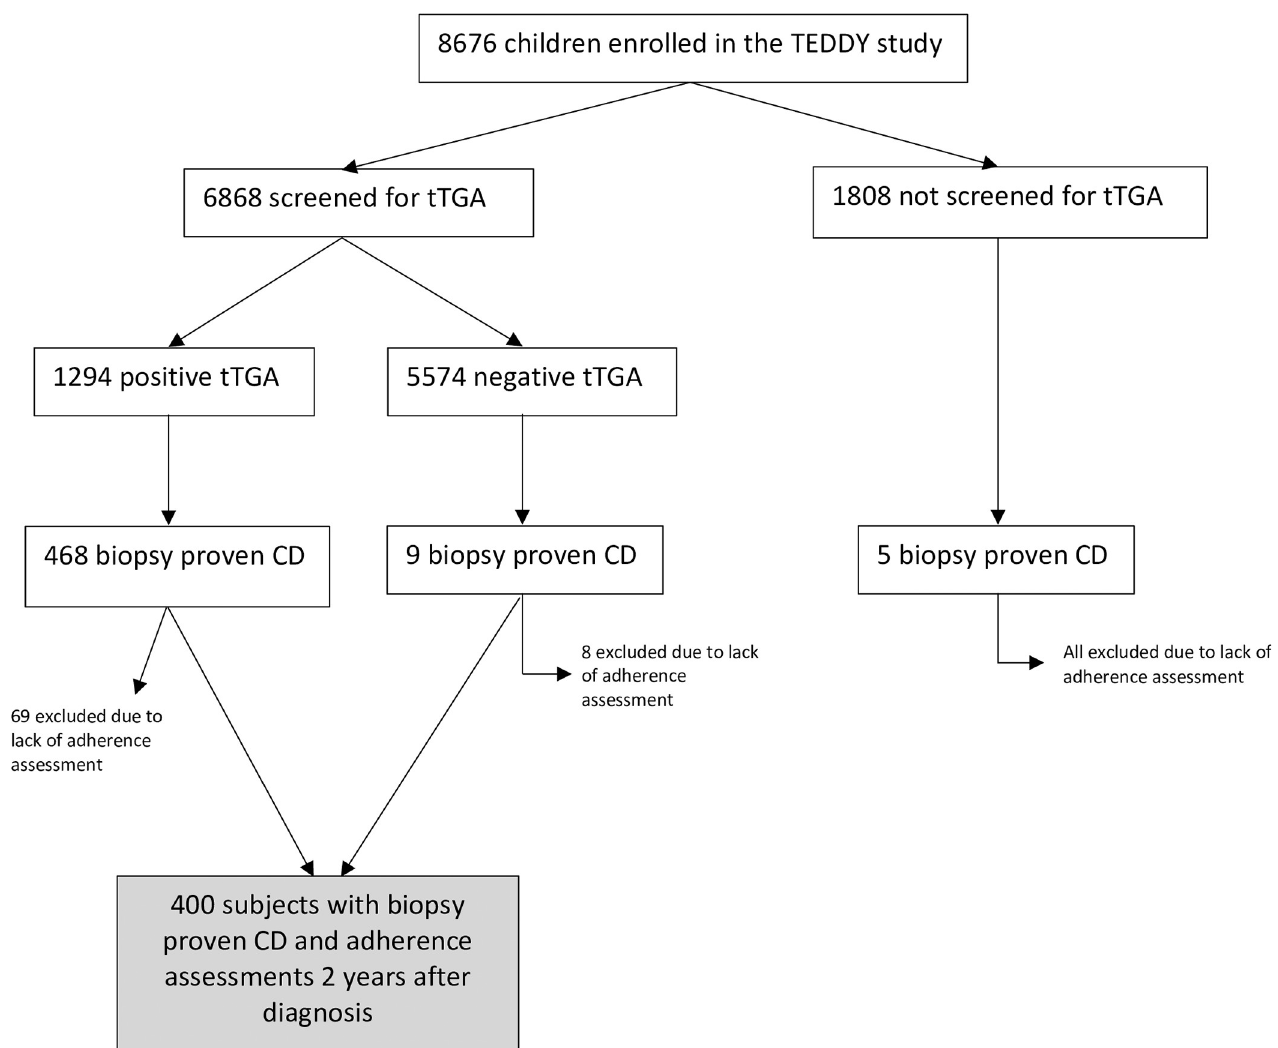
Fig 1. Study population. Inclusion and exclusion criteria for the current TEDDY study. Abbreviations: Celiac disease (CD); The Environmental Determinants of Diabetes in the Young (TEDDY); tissue transglutaminase autoantibodies (tTGA).